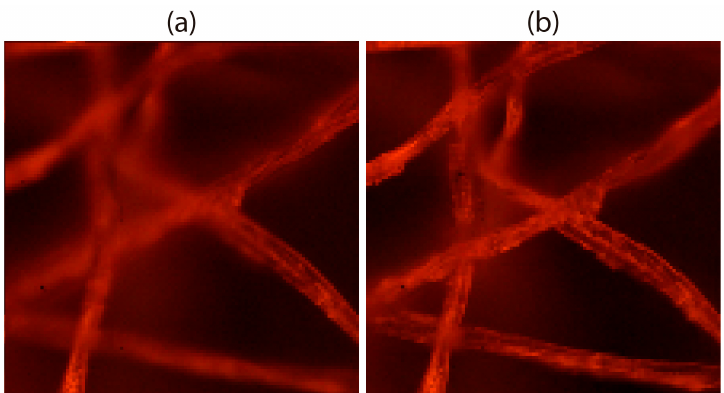
Figure 7. Comparison of the depth of field in perspective views with ( a ) conventional integral microscopy, and ( b ) the proposed method. Note in the last case how the range in which the sample appears sharp is increased.